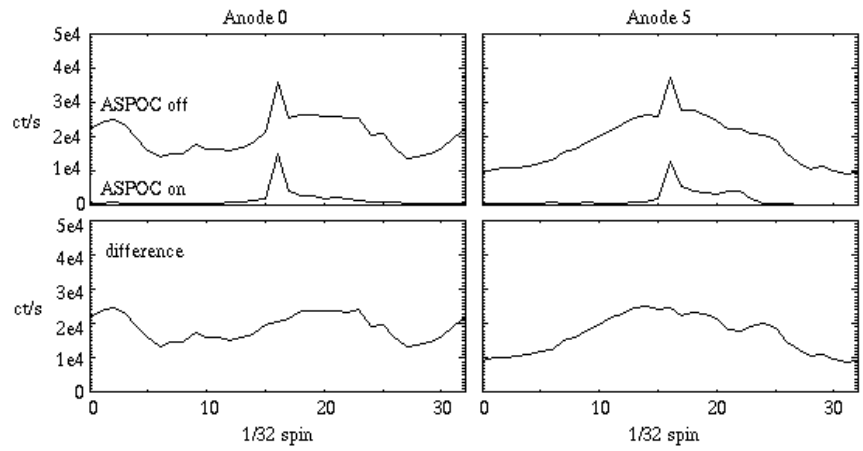
Fig. 7. Superposed data collected at 8–9eV both before and after ASPOC switched on as shown in Fig. 6: anode 0 (look direction along spin axis) on the left, anode 5 (look direction in spin plane) on the right. Top panel shows ASPOC off (upper line) and ASPOC on (lower line) data, lower panel shows the difference between the